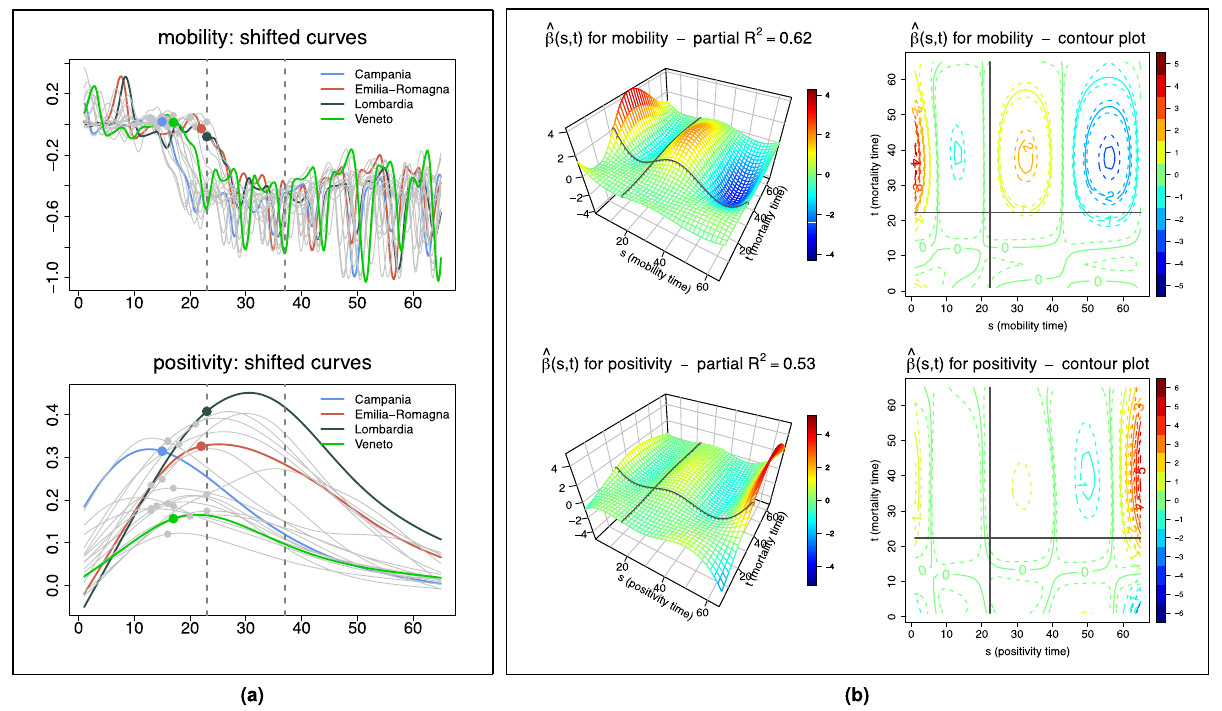
Figure 4. Associating mortality to local mobility and positivity. ( a ) Local mobility curves (Google’s “Groceries & pharmacy”) and positivity curves (regularized ratios of new cases to number of tests performed) in the 20 Italian regions. Curves are smoothed with splines, with degree of smoothing selected by generalized cross- validation, and shifted based on probKMA run on the MAX mortality curves with K = 2 ; time is marked as a day number representing the region-specific time of the epidemic unfolding, and corresponds to actual time (starting on February 16 and ending on April 30) only for regions with no shifts, e.g., Lombardia. Vertical lines show the days corresponding to the nationwide lock-down (March 9) and the suspension of all nonessential production activities (March 23) without shifts, stars on the curves mark the lock-down after the region specific shifts. The example regions of Fig. 1(a) are highlighted in color. ( b ) Estimated effect surfaces from the joint function-on-function regression of MAX mortality on local mobility and positivity shown in 3D and as contour plots (March 9, without shift, is again marked on both). Early and mid-period local mobility levels are strong positive predictors of mortality at its peak. Positivity has similar but much weaker predictive signals,